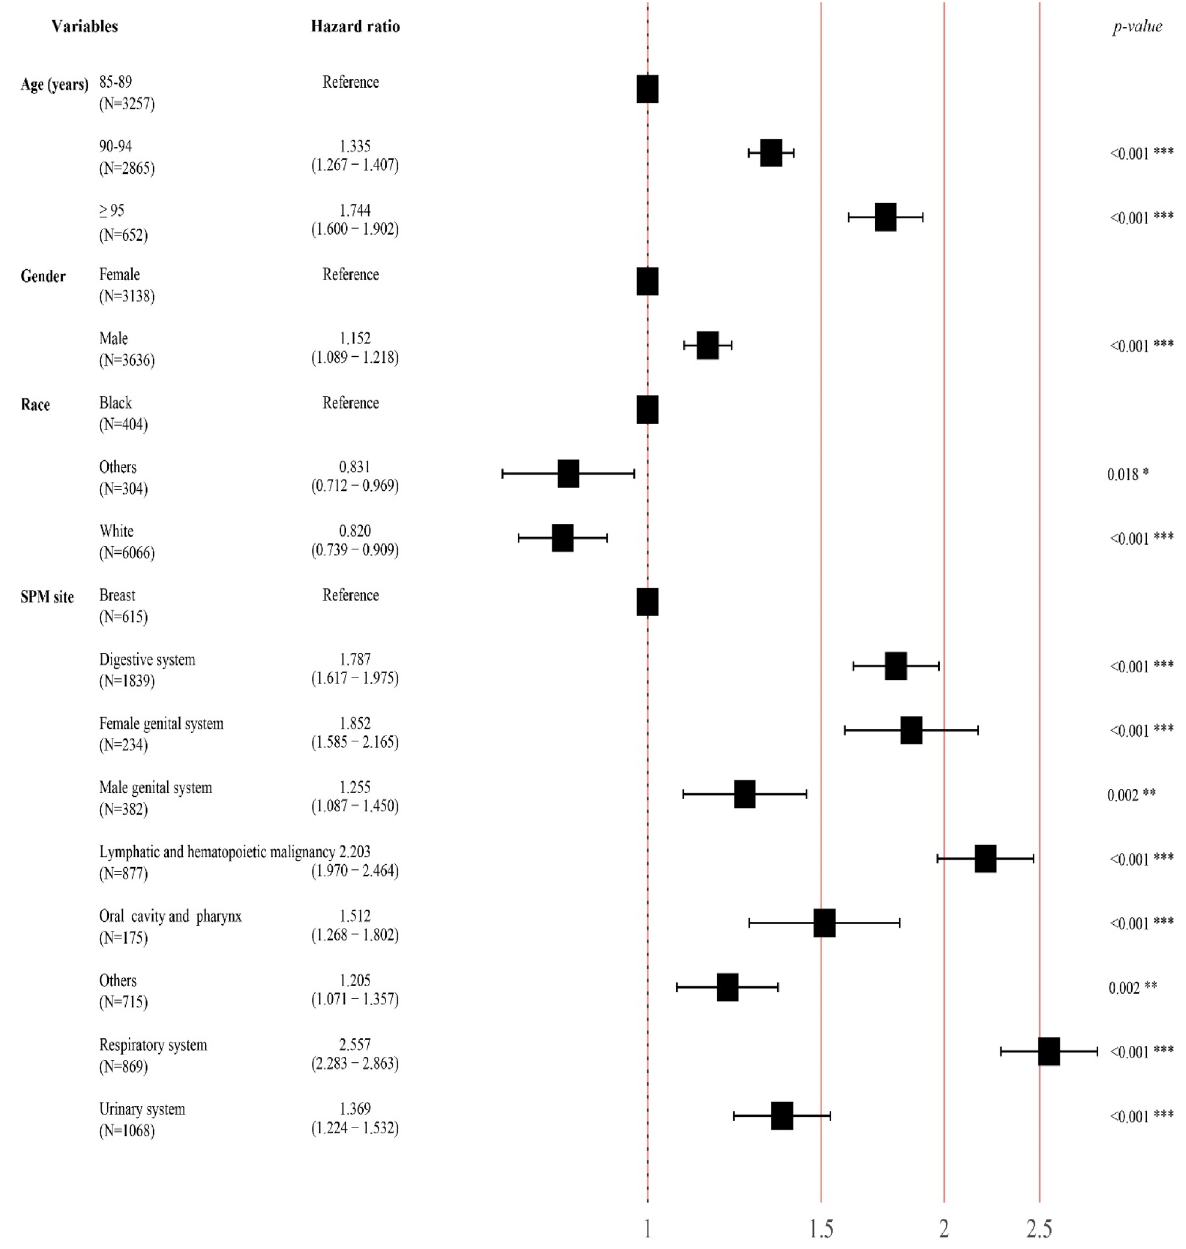
Figure 5. A forest plot displaying the HR and 95% CI of each variable affecting survival after SPM. The square and line segments represent the HRs and 95% CI, and HR > 1.000 indicates a higher risk. HR, hazards ratio; CI, confidence interval; SPM, second primary